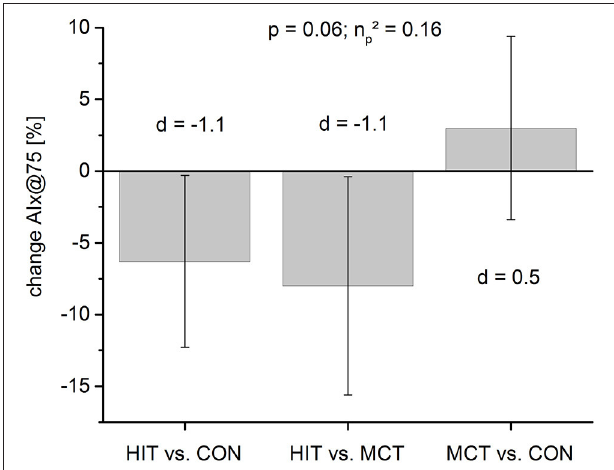
FIGURE 2 | Mean change scores (%) for peripheral arterial stiffness (AIx@75) for pairwise between group comparison. Standardized mean differences are given as Cohen’s d indicating moderate effects for HIT (0.5 < d < 0.7) compared to both groups. MCT vs. CON remains